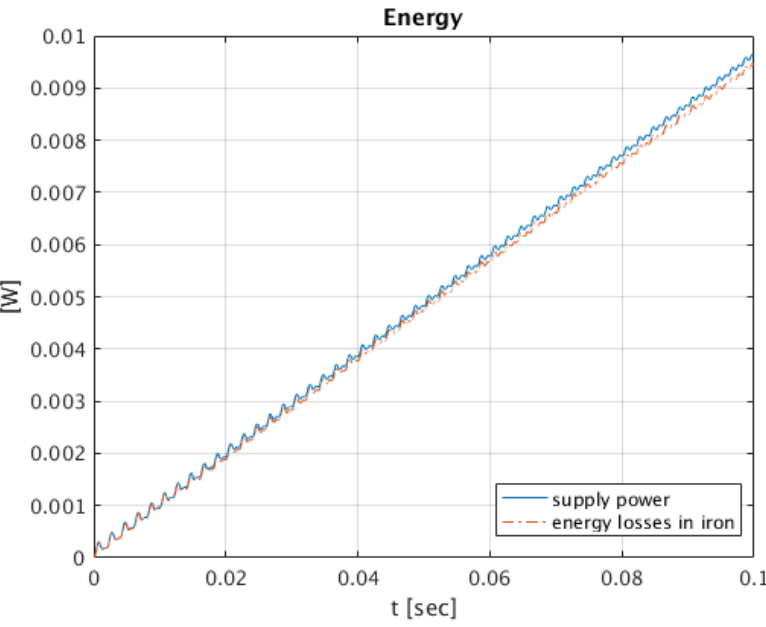
Figure 11. The waveform of the power supply, energy loss in iron, energy loss of resistance, and a zero energy balance for angular frequencies ω = 3141.6 rad